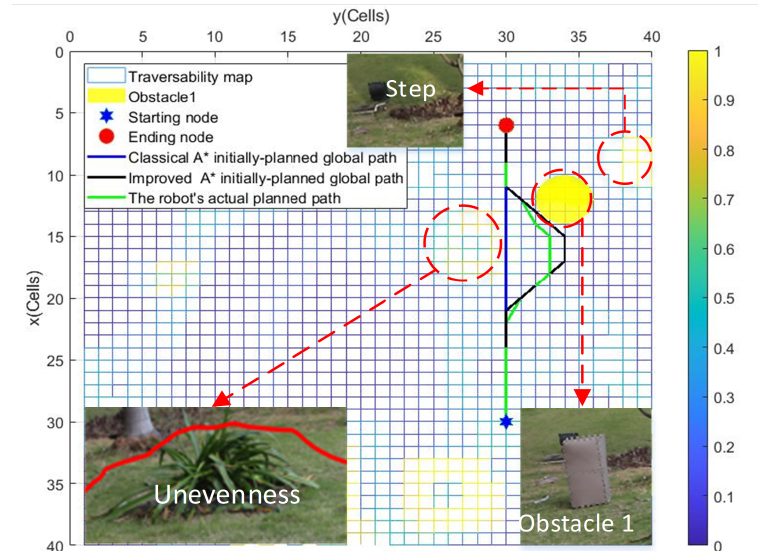
Figure 8. The planned paths in Exp